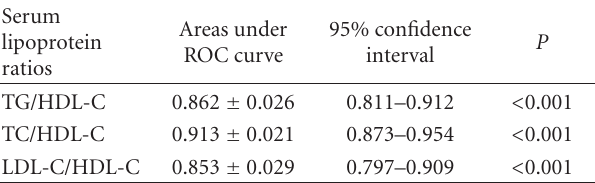
Table 2: Serum lipoprotein ratios and the areas under ROC curve for the detection of PCOS with insulin